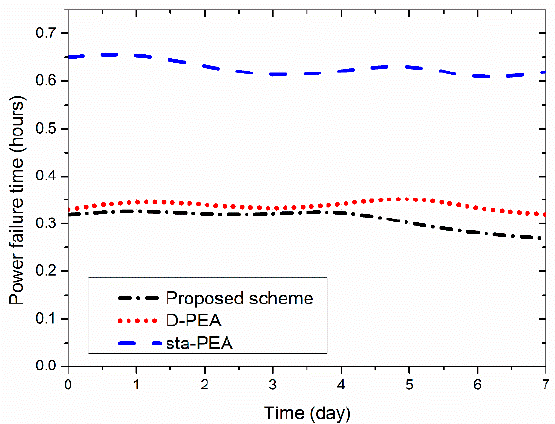
Figure 13. Power failure time t f